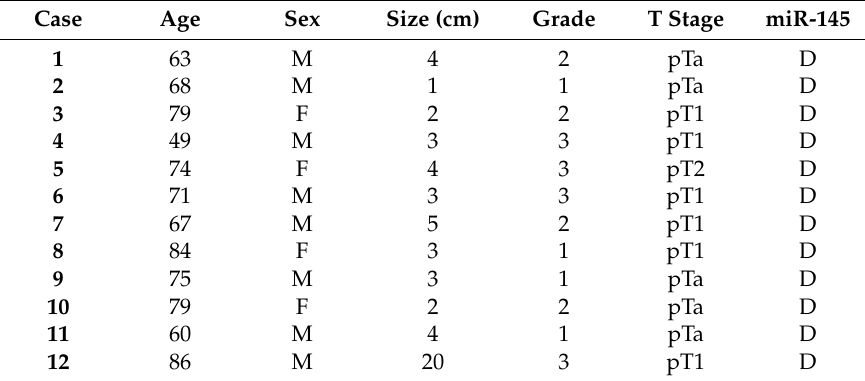
Table 1. Clinicopathological patient